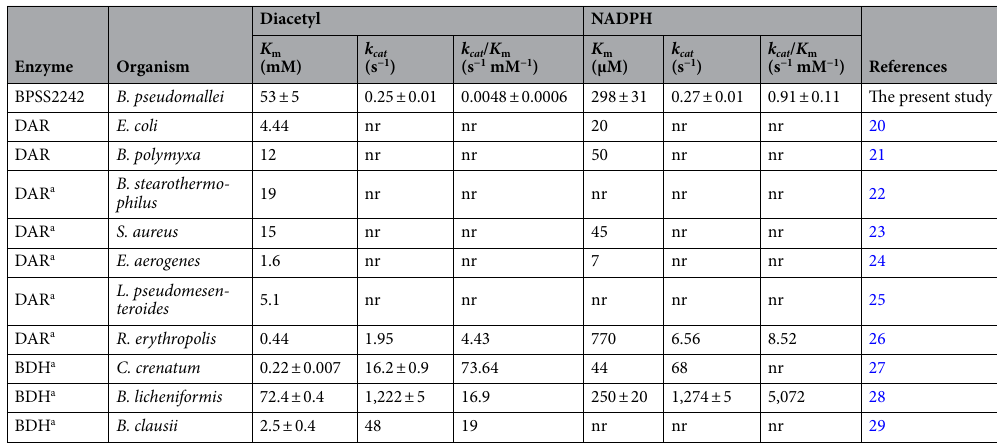
Table 4. Kinetic constants of BPSS2242 and bacterial enzymes known to have diacetyl reductase activity. a NADH was used as a cofactor. DAR, diacetyl reductase and BDH, 2,3-butanediol dehydrogenase. nr not